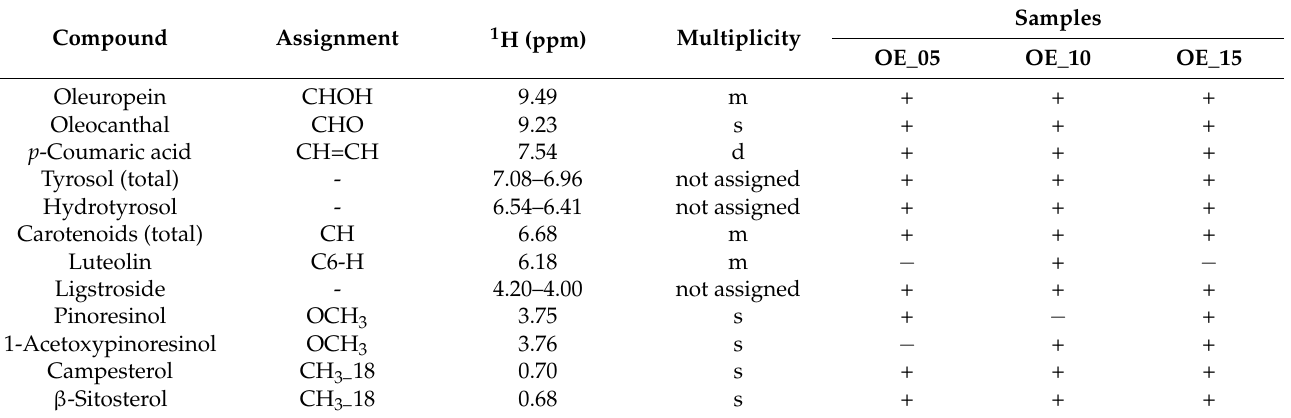
Table 3. 1 H NMR qualitative analysis of the major components in EVOO extracts OE_05 , OE_10 , and OE_15